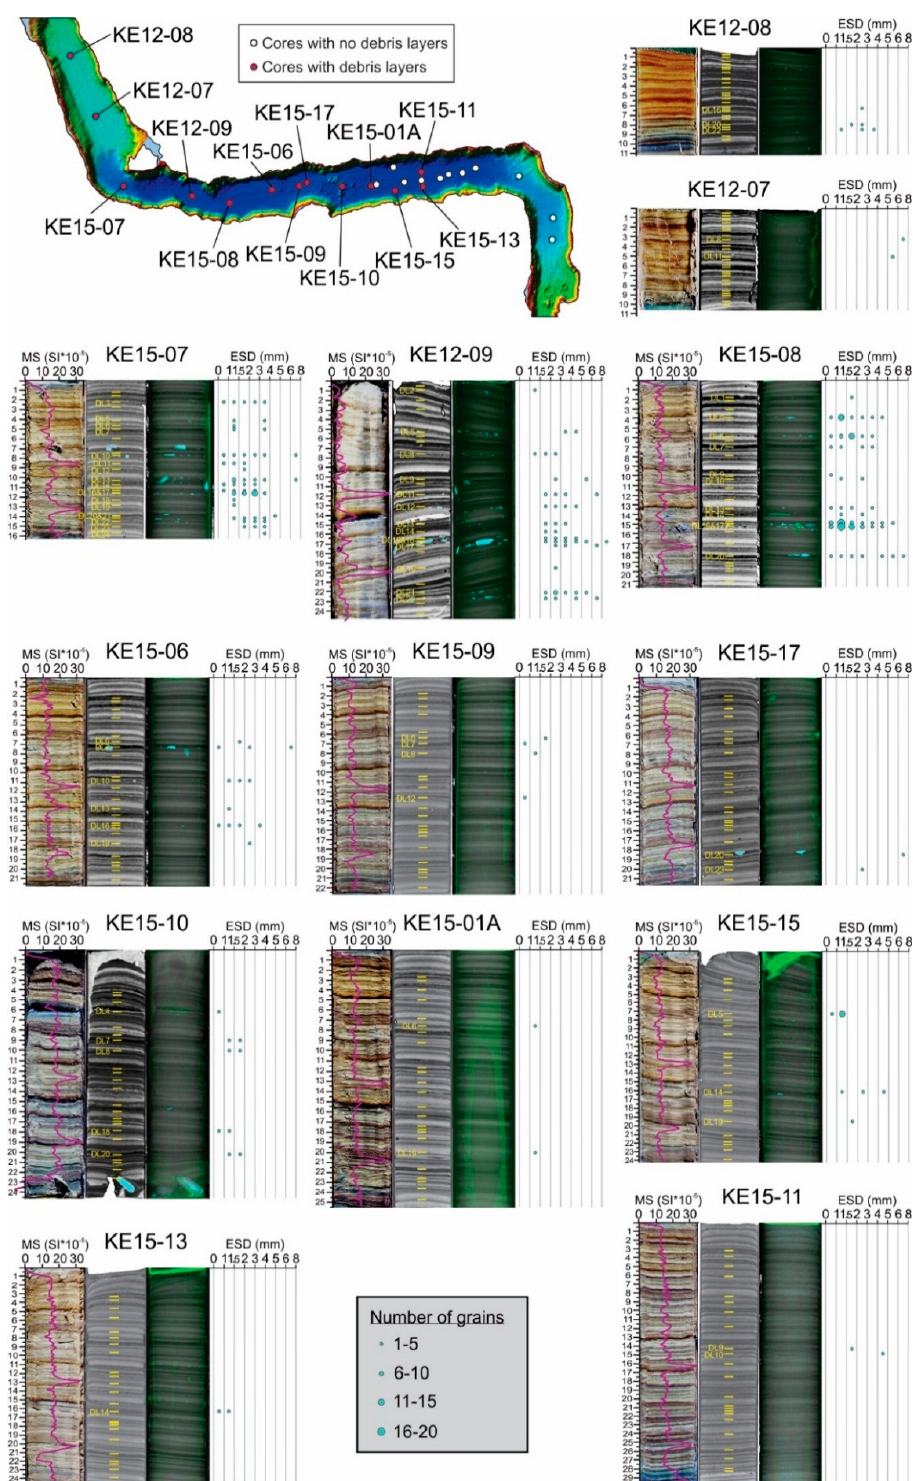
Figure 5. Overview of all cores from Kenai Lake where snow-avalanche debris was found. For each core there is from left to right: photograph of the core with enhanced colour histogram, frontal cross-section of the “soft tissue” reconstructed image. X-ray CT “sum-along-ray” (equivalent to inverted radiograph) image of the “bone” reconstructed image stack and a plot with the number of grains found per debris lamina for different classes of equivalent spherical diameter (ESD).